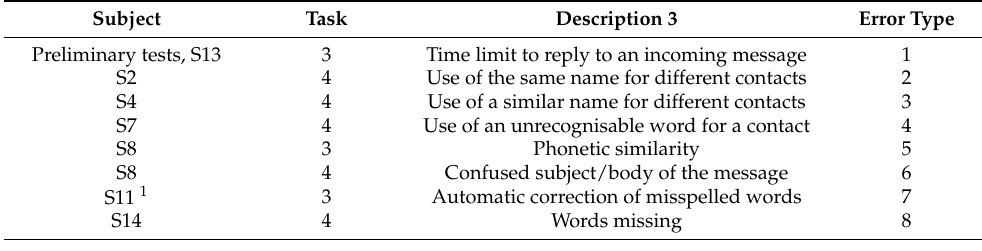
Table 4. Issues with the virtual